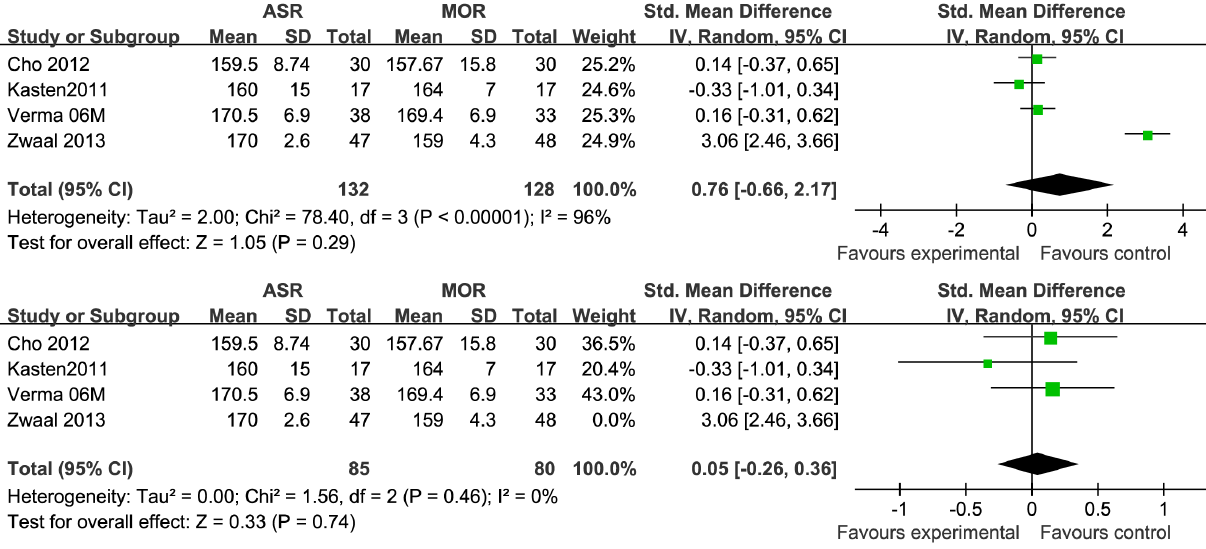
Figure 2. Forest plot showing the SMD (Standardized mean difference) and 95% CI for Forward flextion after surgery with and without the study by Zwaal 13 during a sensitivity analysis. The heterogeneity decreased significantly when the study by Zwaal et al was excluded.